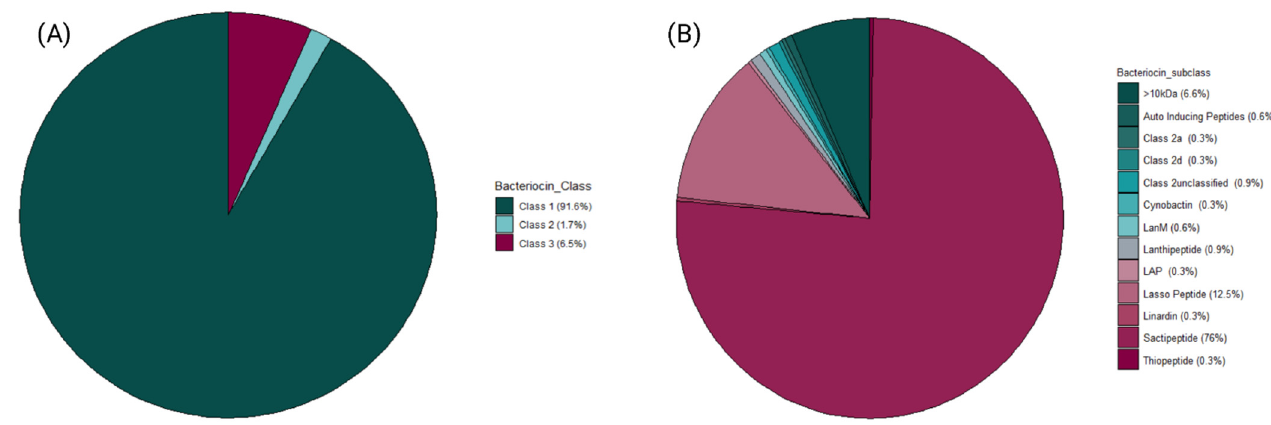
Figure 3. Frequency of bacteriocin classes and their subsequent t subclasses predicted by BAGEL4 from the recovered MAGs. Class I, II, and III bacteriocins were predicted, with Class_1 (including Sactipeptide sub-group) found to be the most abundant predicted bacteriocin class within the athlete gut sampled in this study. Sactipeptides and Lasso peptides were amongst the most predicted bacteriocin sub-classes, followed by >10 kDa. ( A ) Contains all bacteriocin classes predicted by BAGEL4 software ( B ) Contains all bacteriocin sub-classes predicted by BAGEL4 software.